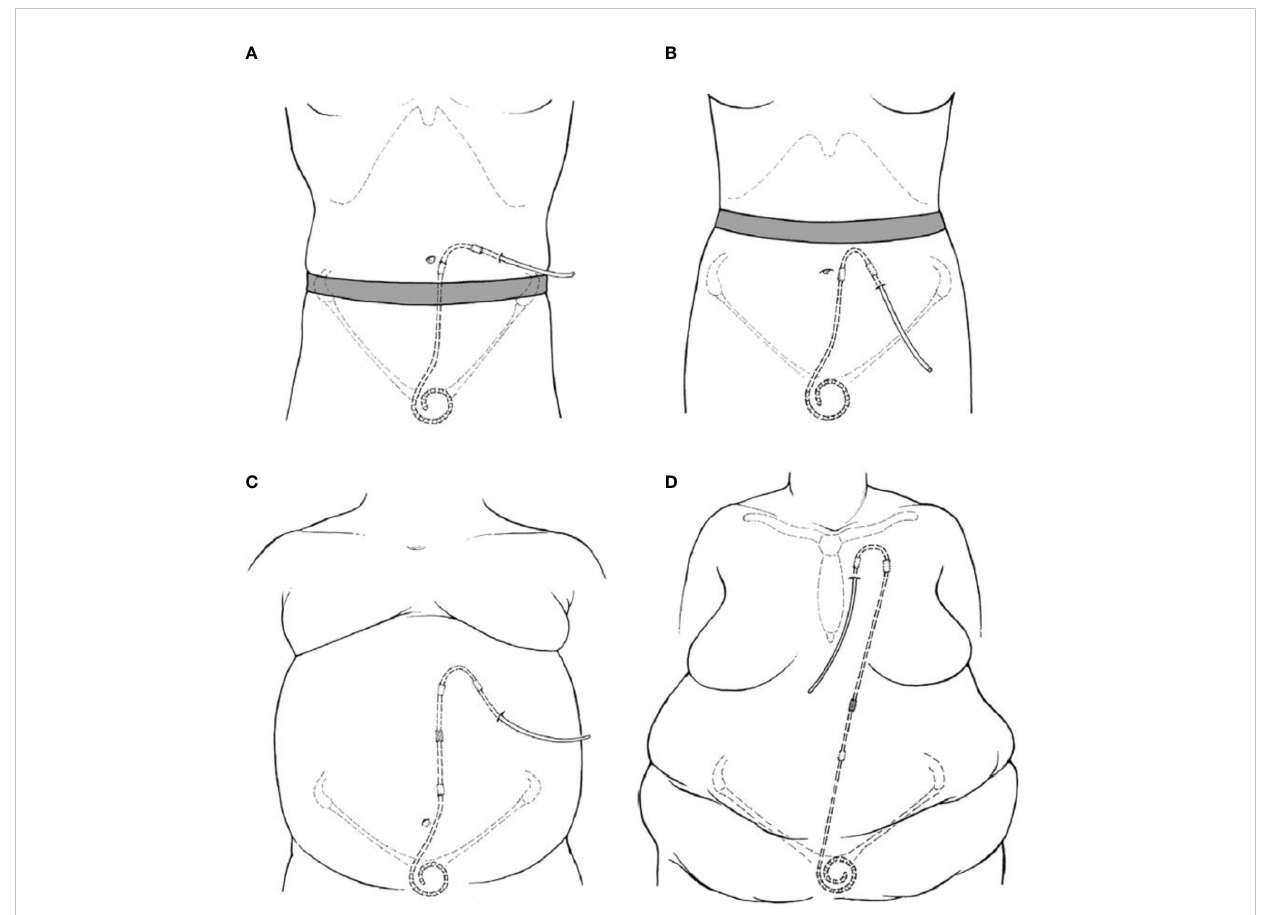
FIGURE 1 Illustrations of PD catheter positions with regards to exit site position (A) Laterally directed exit site emerging above the beltline. (B) Downward directed exit site below a high beltline. (C) Extended catheter system with an upper abdominal exit site. (D) Extended catheter system with a presternal exit site